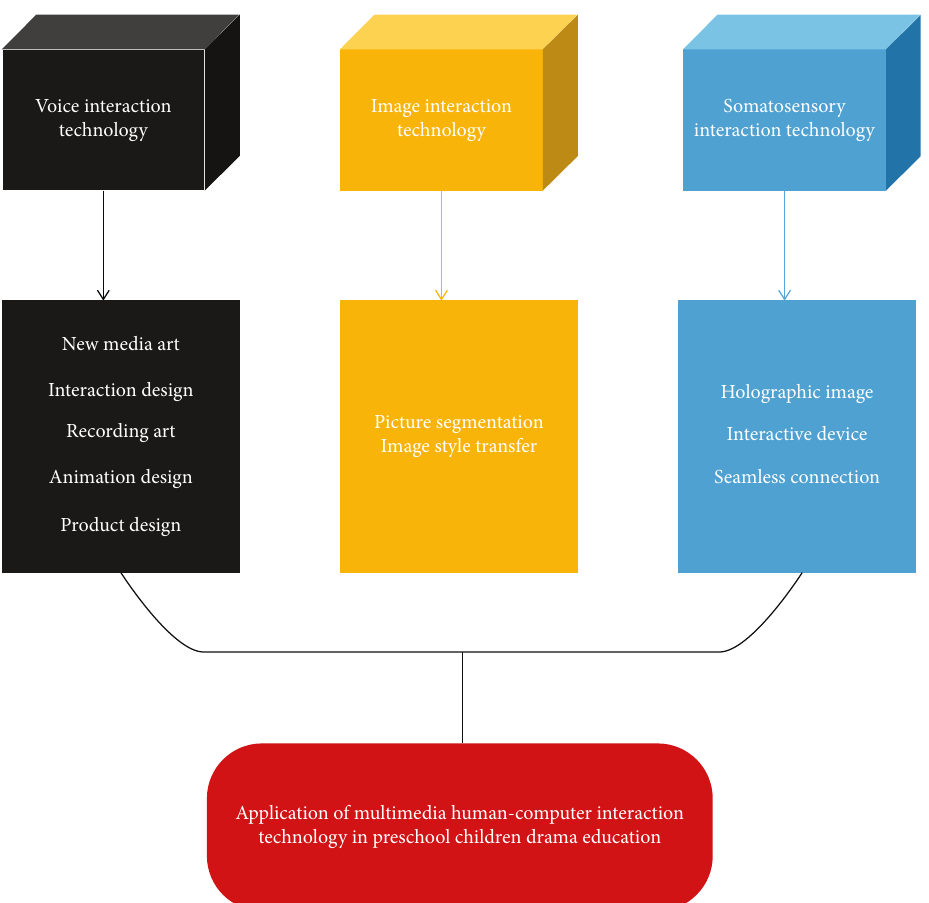
Figure 4: Application of multimedia human-computer interaction technology in preschool children drama education.